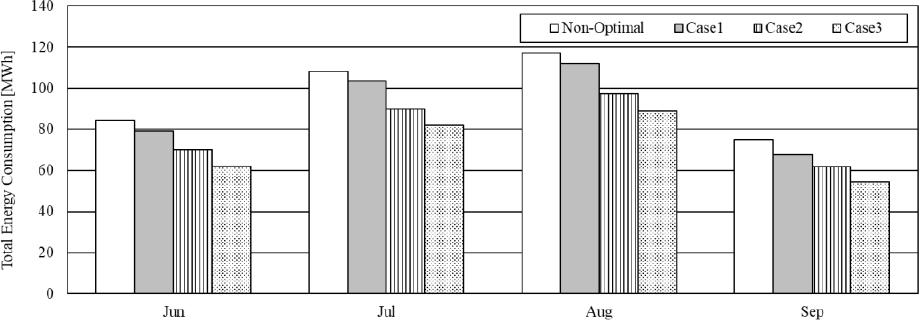
Figure 8. Monthly energy consumption comparison between normal operation mode and optimal operation modes for June through September.